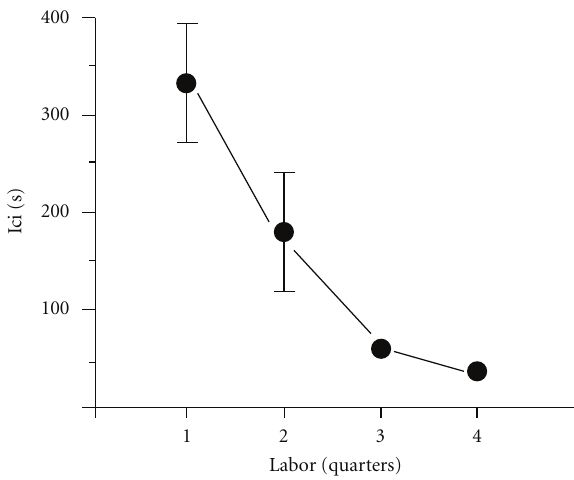
Figure 2: Intercontraction intervals (ici) during pre-birth labor recorded from rat dams ( n = 8) from